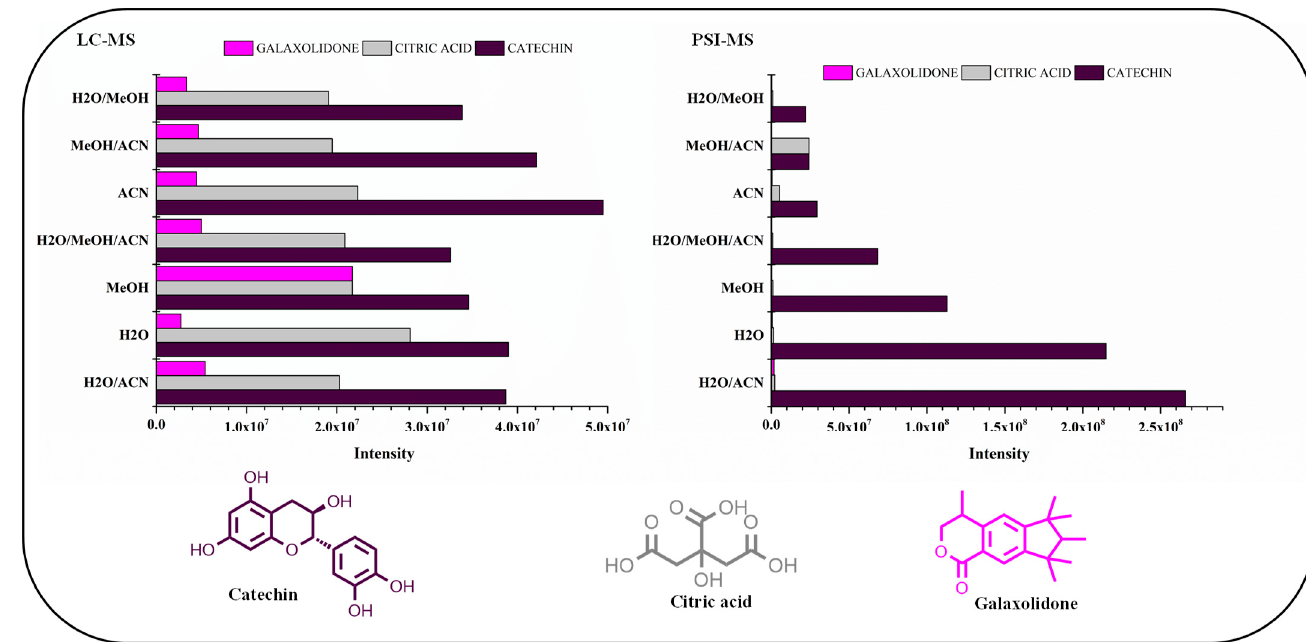
Figure 6. Relative abundance of the major compounds annotated from cupuassu ( T. grandiflorum ) pulp extract samples using mixtures of acetonitrile/methanol/water obtained in LC-HRMS/MS and PSI-HRMS/MS analyses.